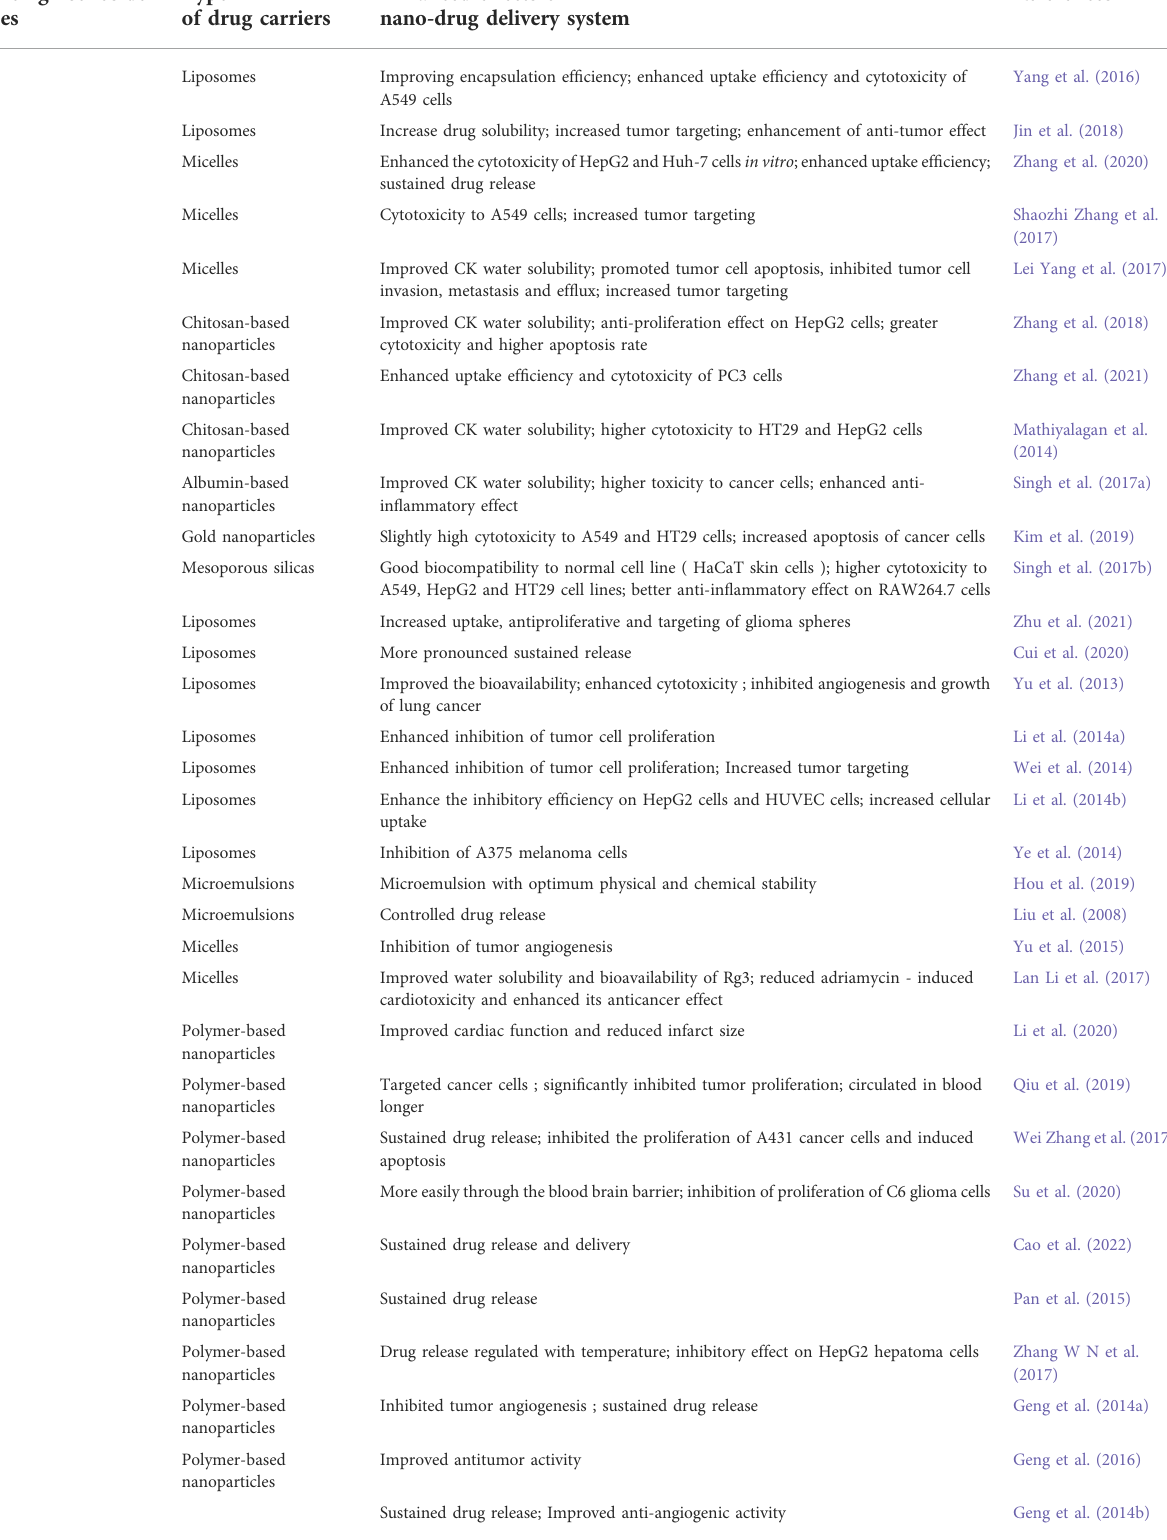
TABLE 1 Enhanced effect of minor ginsenoside nano drug delivery system on minor